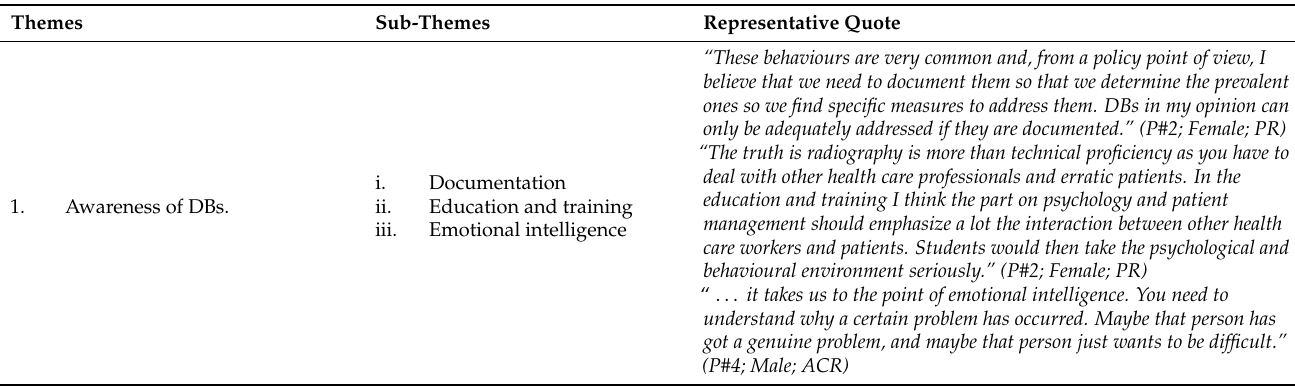
Table 2. Themes emerging from the interview